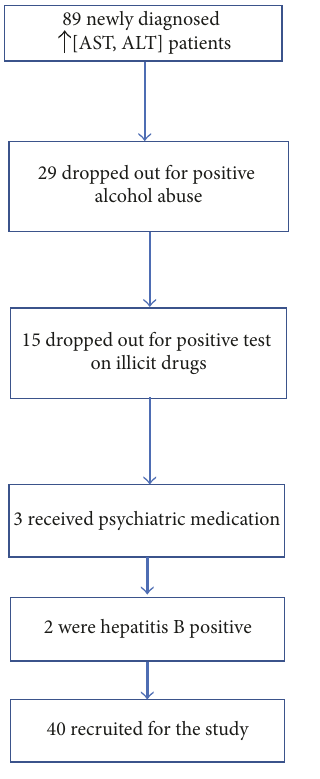
Figure 1: Flow diagram of patient selection from Department of